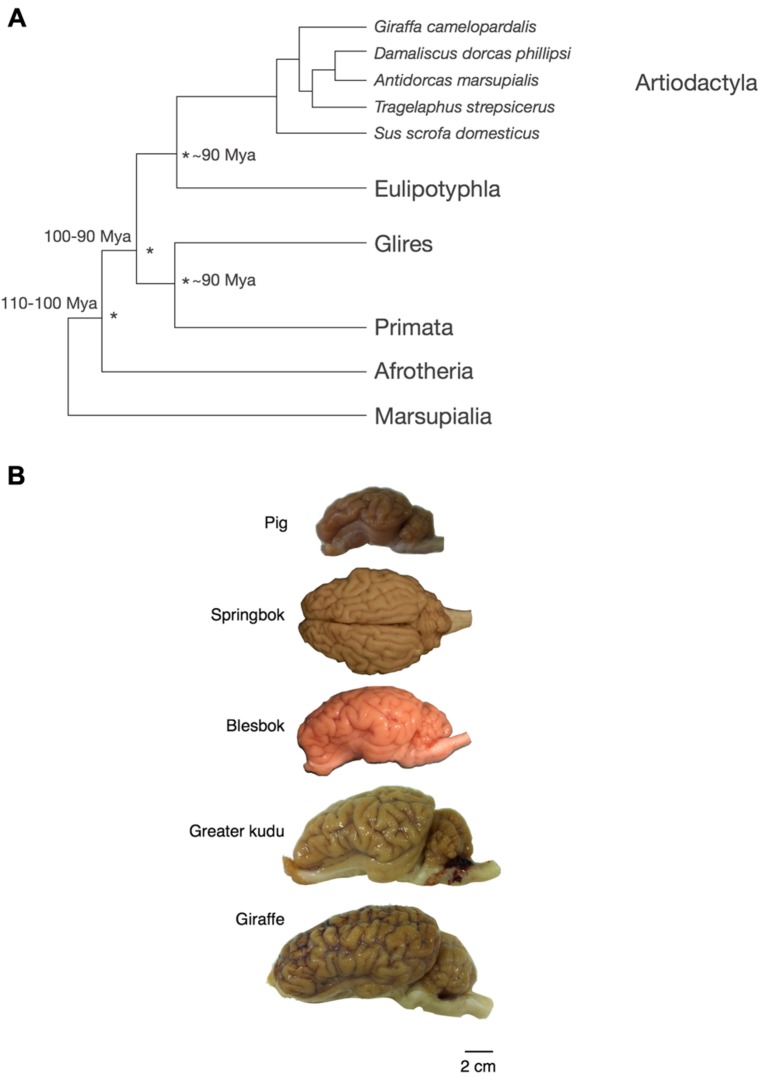
Phylogenetic relationship and appearance of the artiodactyl brains used in this study. (A) Phylogenetic relationship across the artiodactyl species examined here and other mammals investigated previously. (B) Appearance of the artiodactyl brains used in this study. Scale bar, 2 cm. The springbok brain is shown in a dorsal view, while the lateral view of the left hemisphere is shown for the other species.